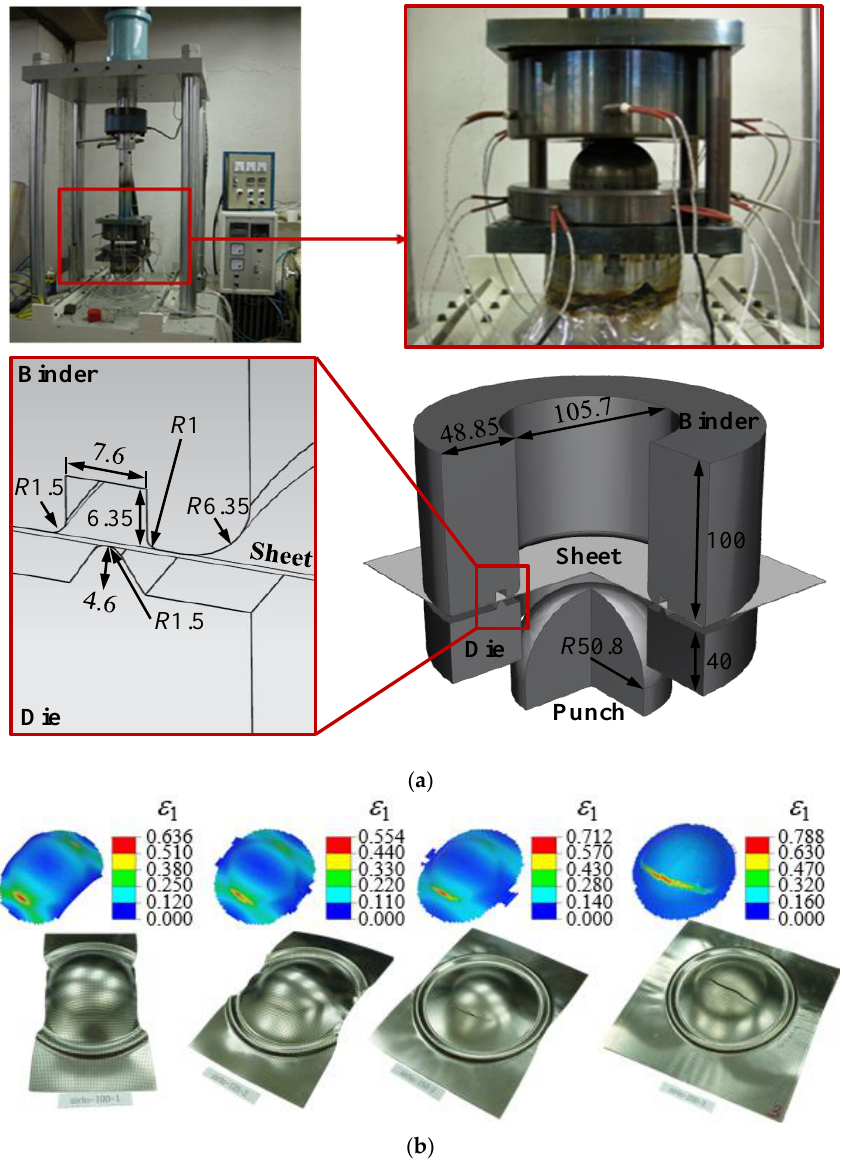
Figure 7. ( a ) Limit dome height (LDH) test machine and draw bead geometry. ( b ) Distributions of ε 1 for 100, 125, 150, and 200-width specimens.